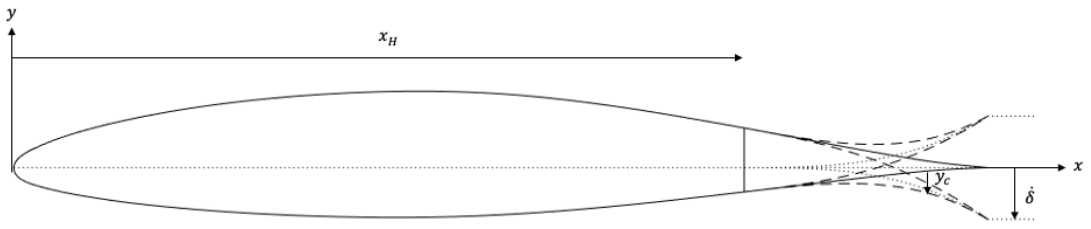
Figure 2. Geometry of the NACA65 1 213 airfoil with integrated aileron deflection.